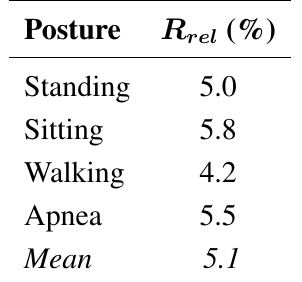
Table 6. Absolute value of the relative error, R signal processing, as described in Section